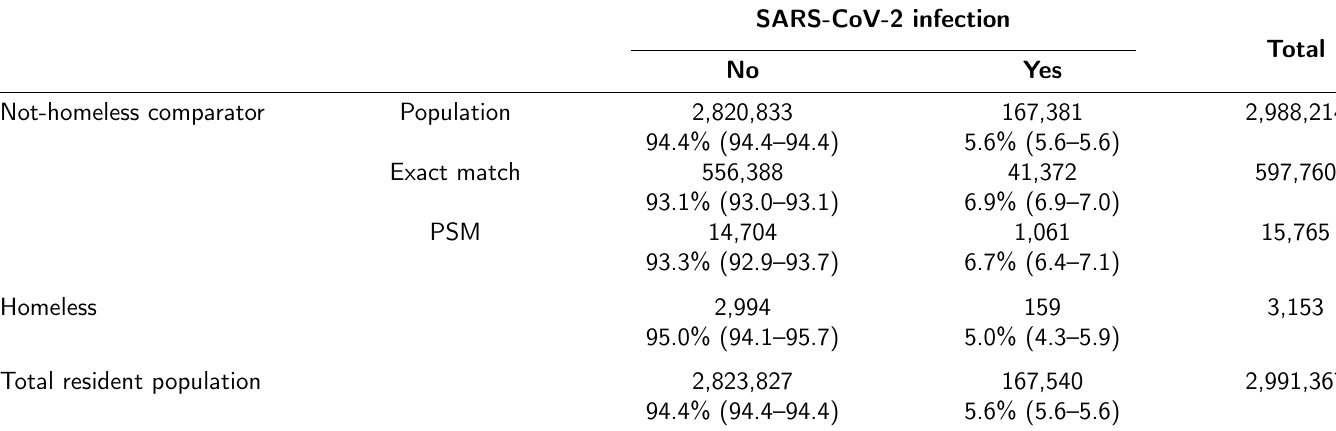
Table 3: Summary of SARS-CoV-2 infection by 1 st March 2021; counts and point estimate of prevalence (95% confidence interval)